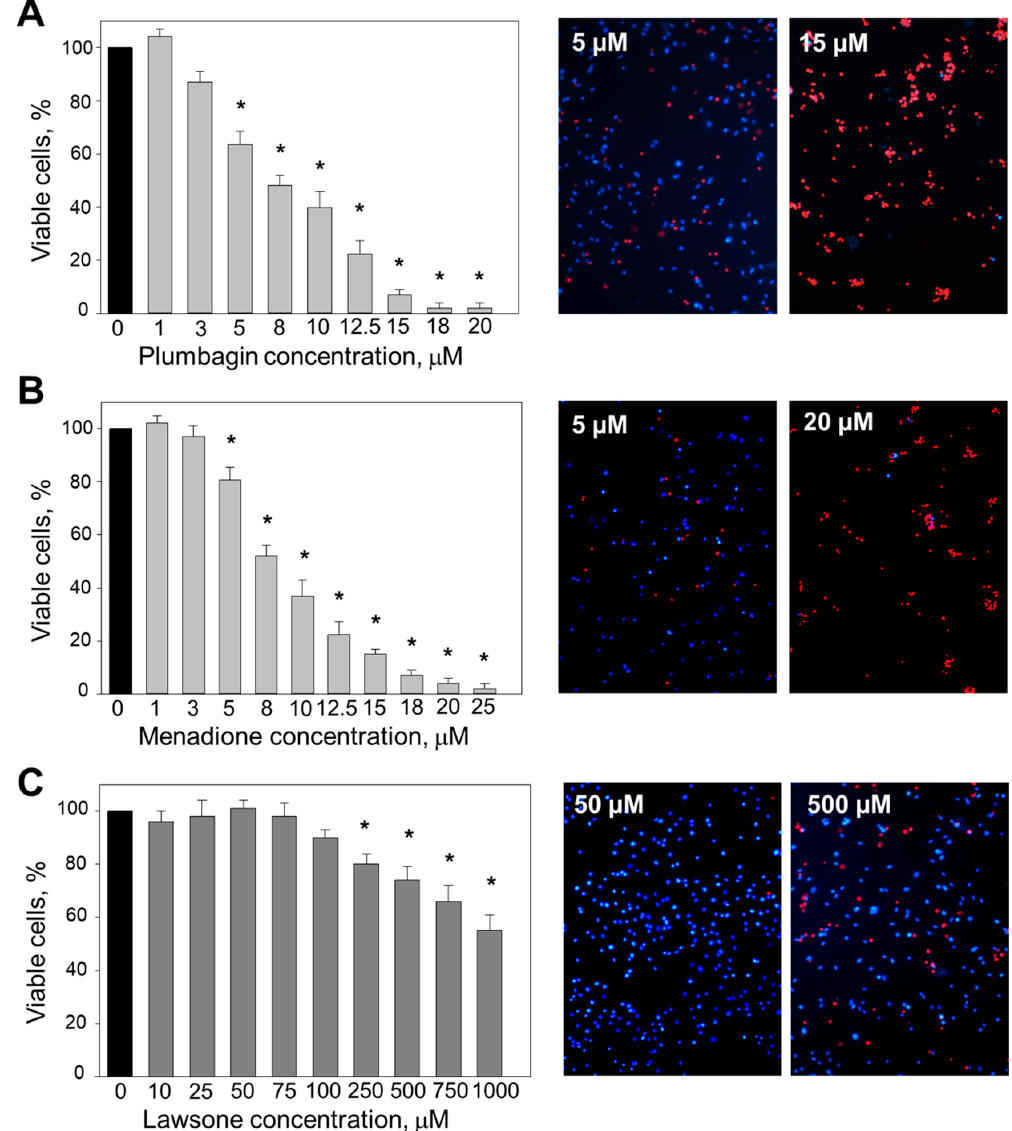
Figure 2. Effects of different concentrations of (A) plumbagin, (B) menadione, and (C) lawsone on the viability of C6 cells. Cell viability was assessed using (1) the MTT method and (2) double-staining with Hoechst 33342 and propidium iodide (PI). Hoechst 33342-positive cells, but lacking PI staining, were considered viable cells. PI-stained cells were considered necrotic. Data are presented as means of the percentage of the total cell number per micrograph ± SE ( n = 5). * p < 0.05 versus control.